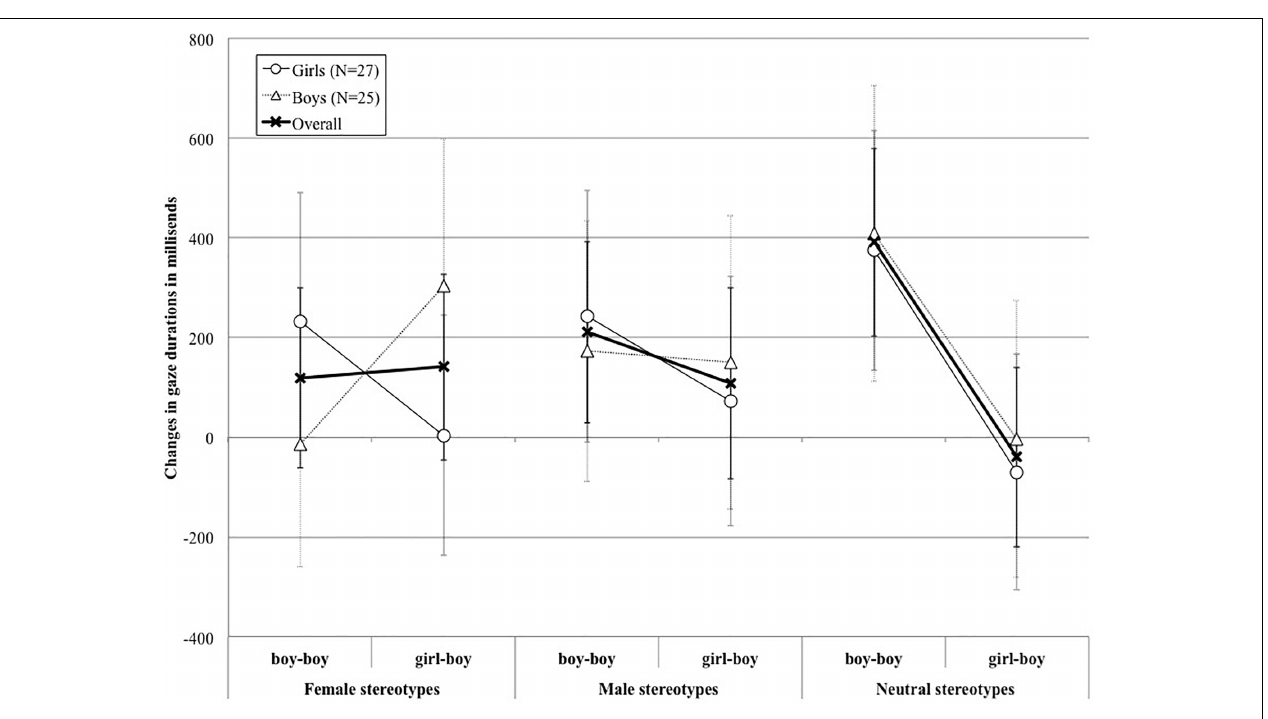
only one potential effect, that of grammatical gender (and not stereotype). For our Picture factor, the contrasts for our model were calculated with the boy-boy picture as the base